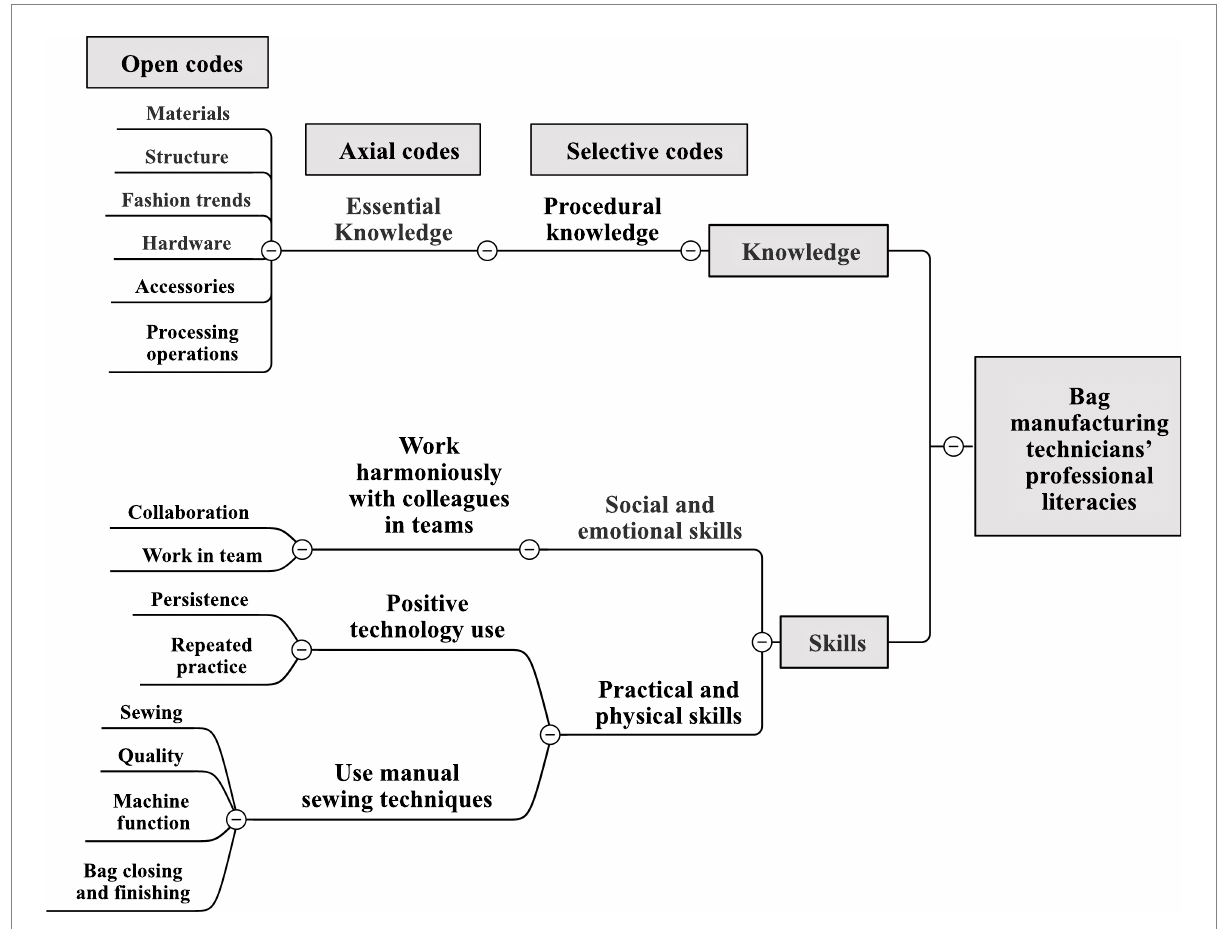
FIGURE 3 Bag manufacturing technicians’ professional literacies